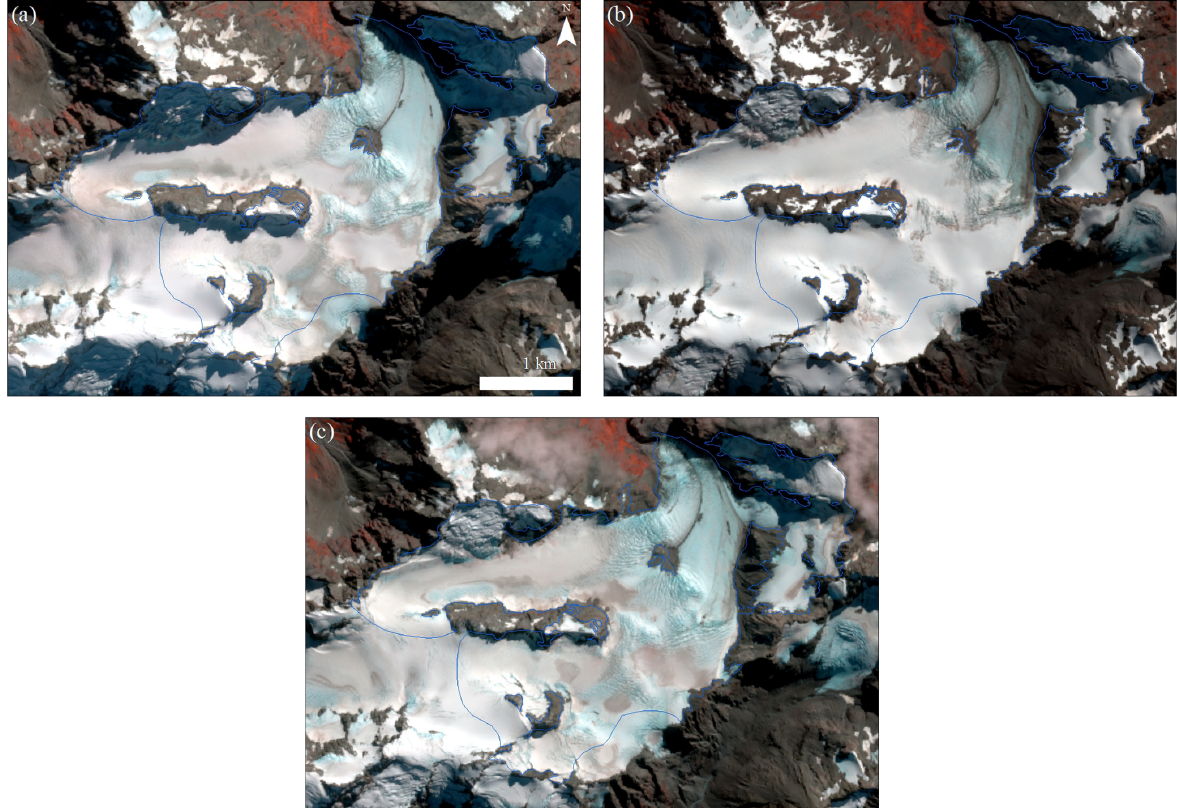
Figure 9. Maximum elevation of the seasonal snowline (approximating the point of maximum ablation) on Lambert Glacier (outlined in blue) observable in cloud-free Sentinel-2A and Sentinel-2B images from (a) 30 April 2016, (b) 29 March 2017 and (c) 29 March